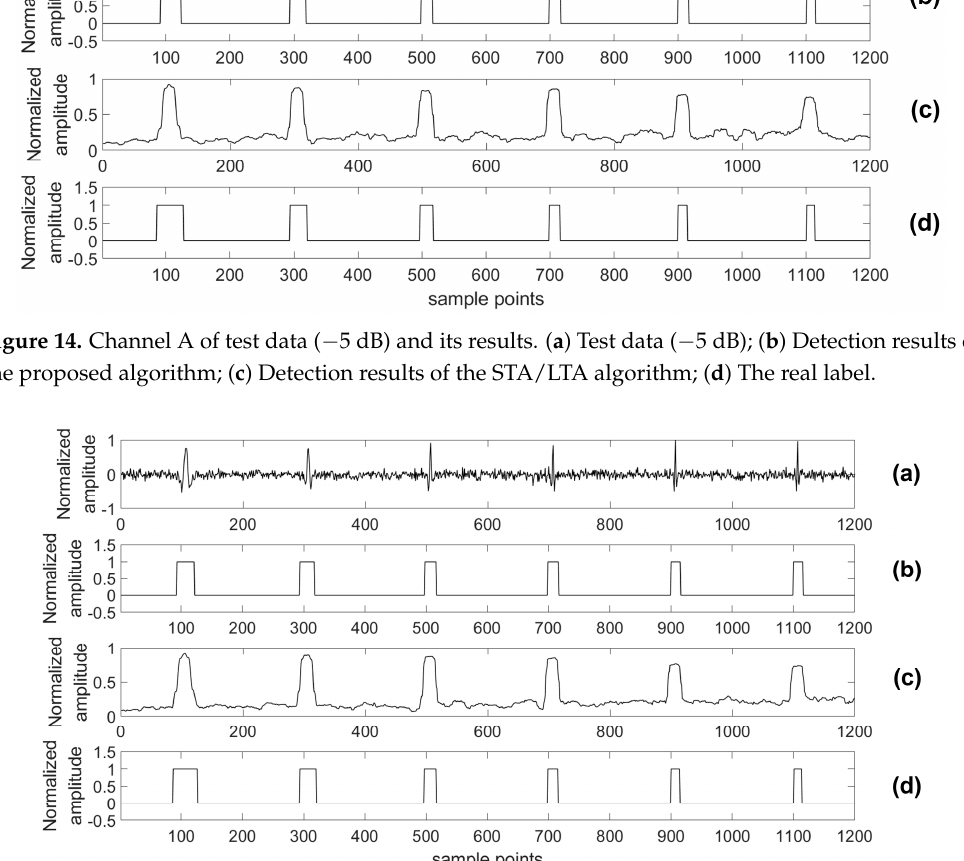
Figure 15. Channel B of test data ( − 5 dB) and its results. ( a ) Test data ( − 5 dB); ( b ) Detection results of the proposed algorithm; ( c ) Detection results of the STA/LTA algorithm; ( d ) The real label.